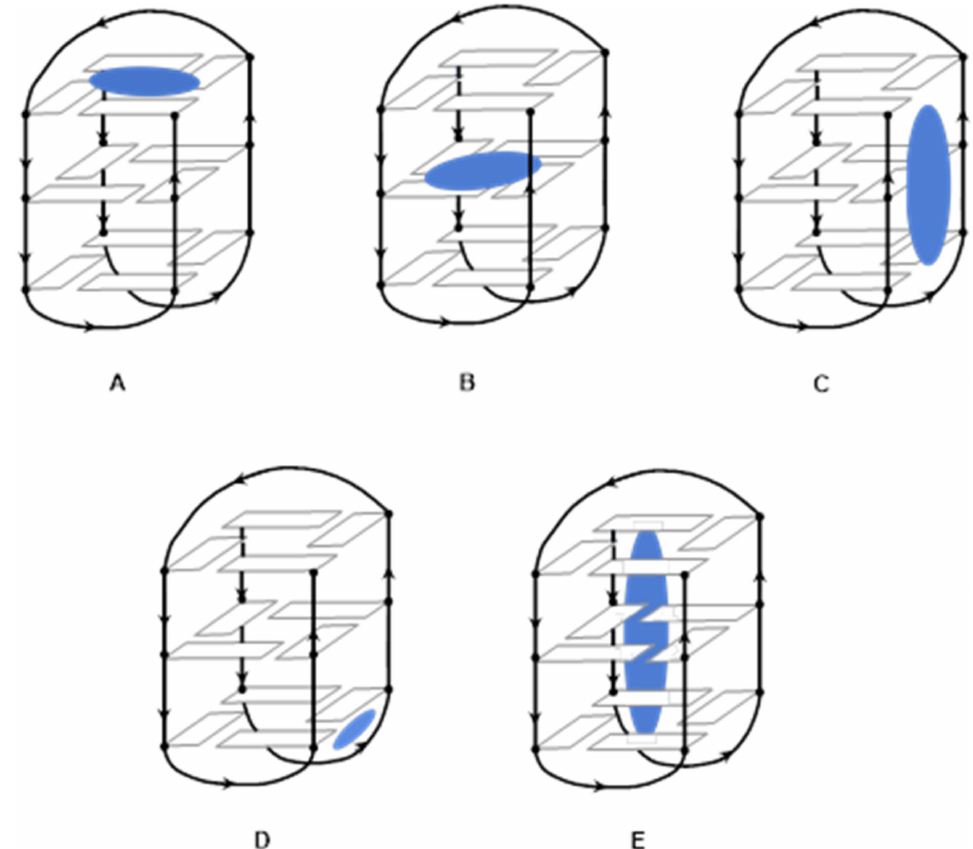
Figure 4. Interaction geometries between a G4-ligand and a G-quadruplex structure. ( A )—( π -stacking) on an external quartet. ( B )—intercalation between tetrads. ( C )—interaction within a groove. ( D )—interaction within a loop. ( E )—interaction within the central